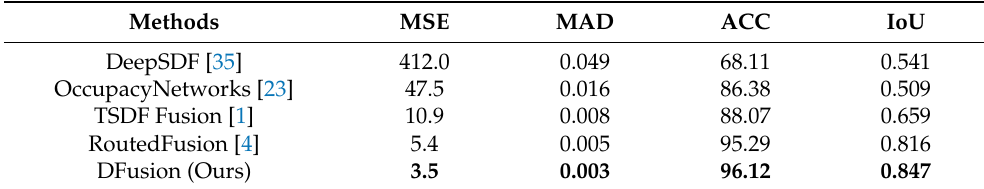
Table 1. Comparison results on ShapeNet (with only depth noise).